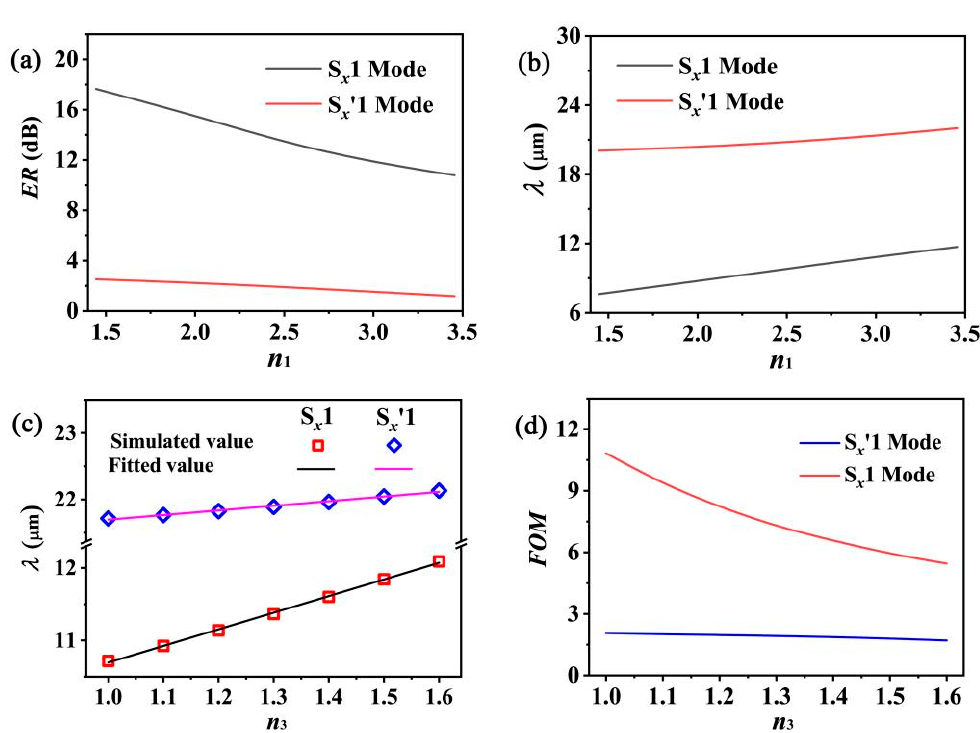
Figure 6. ( a , b ) show the ER values and the resonant wavelength as a function of n 1 for the two modes, respectively. ( c , d ) show the resonant wavelength and the figure of merit ( FOM ) as a function of n 3 for the two modes.